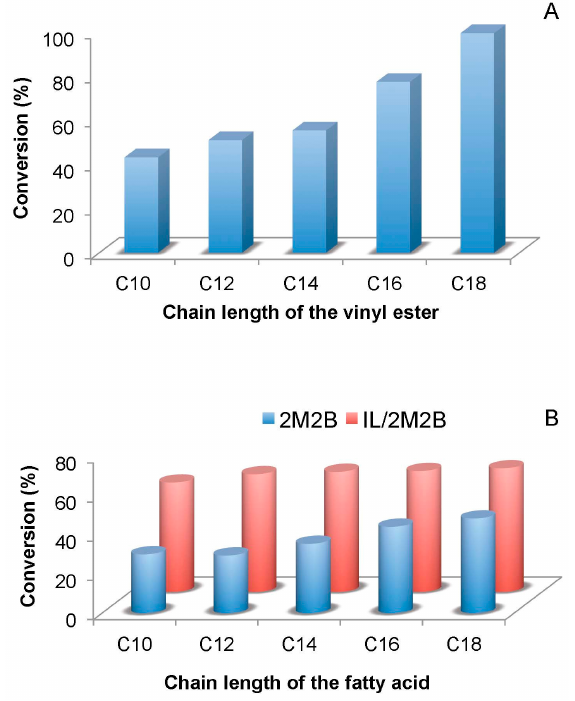
Figure 6. Variation of conversion with fatty acid chain length: ( A ) Lipozyme TLIM-catalyzed transesterification of glucose with various fatty acid vinyl esters for 7 h in [HMIm][TfO]/2M2B bisolvent system (3:7, v/v ); ( B ) Novozym 435-catalyzed esterification of methyl glucoside with fatty acids with different chain lengths in 2M2B for 21 h and in [HMIm][TfO]/2M2B bisolvent system (0.05:0.95, v/v ) for 24 h. C10, C12, C14, C16, and C18 refer to vinyl esters or acids of caprate, laurate, myristate, palmitate, and stearate, respectively. Reaction conditions for (A): 0.3 M of glucose, 0.3 M of vinyl ester, 100 mg of molecular sieves, 33.9 mg of Lipozyme TLIM, and 1.0 mL of IL/2M2B (0.2:0.8, v/v ), 55 °C, 7 h. Conditions used for ( B ) in 2M2B: 0.3 M of methyl glucoside, 0.3 M of fatty acid, 100 mg of molecular sieve, 100 mg of Novozym 435, and 1.0 mL of 2M2B, 45 °C, 21 h. Conditions used for ( B ) in IL/2M2B bisolvent system: 0.3 M of methyl glucoside, 0.3 M of fatty acid, 150 mg of molecular sieve, 10 mg of Novozym 435, and 1.0 mL of [HMIm][TfO]/2M2B (0.05:0.95, v/v ), 45 °C, 24 h.